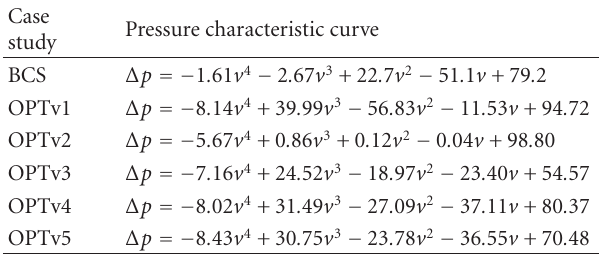
Table 2: Fan boundary condition: Fan pressure characteristic curves—OPTv case